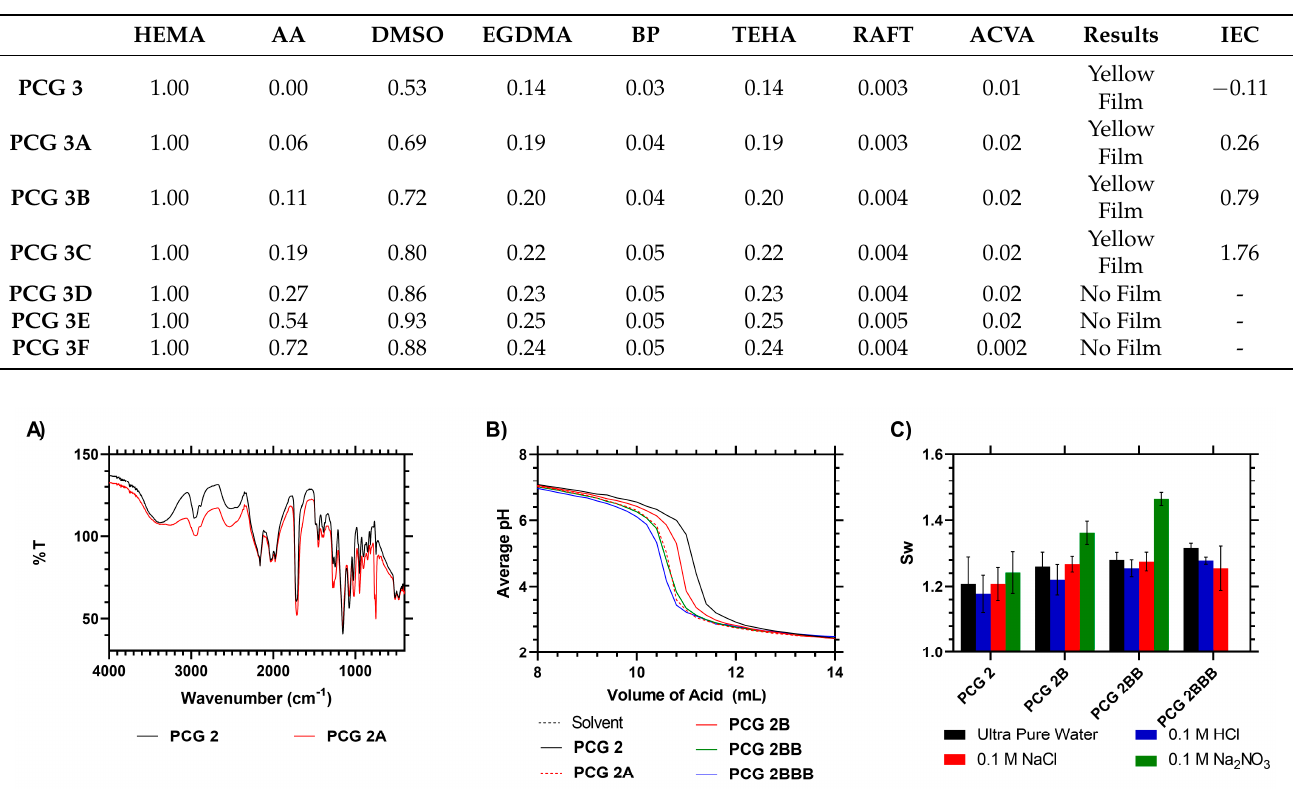
Figure 3. ( A ) IR analysis of AA-grafted RAFT–HEMA films. ( B ) Raw titration data of AA-grafted RAFT–HEMA films. ( C ) S w of AA-grafted RAFT–HEMA films at different pH levels.